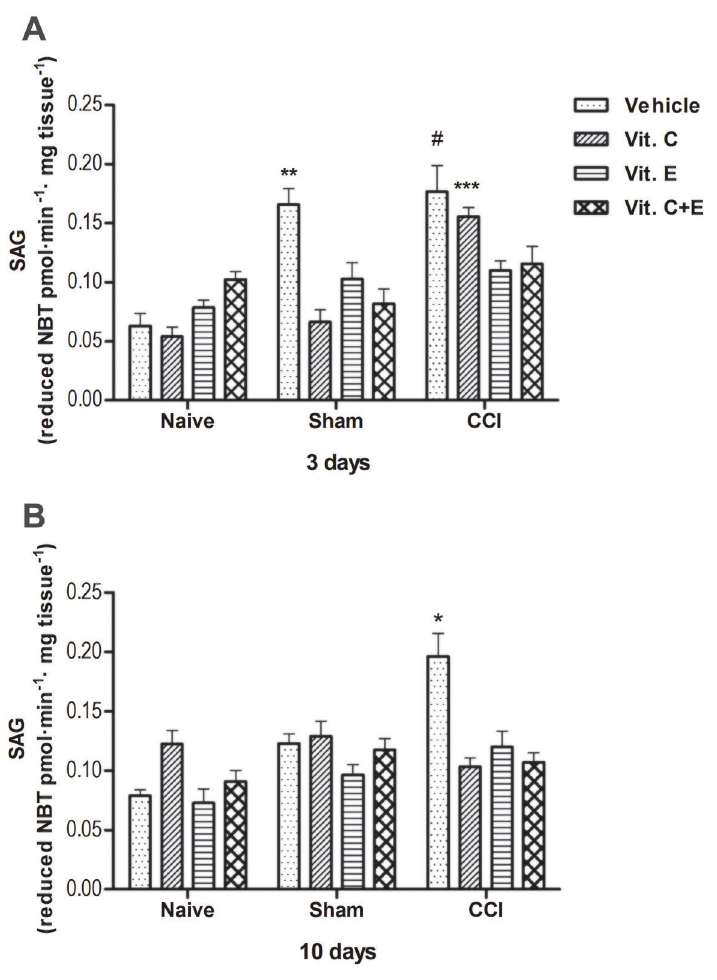
experimental group. Despite not signi fi cant, the lipid hydro- peroxides decreased 33% in spinal cord of vit. C-treated CCI rats. No signi fi cant change was found in sham and naive rats.